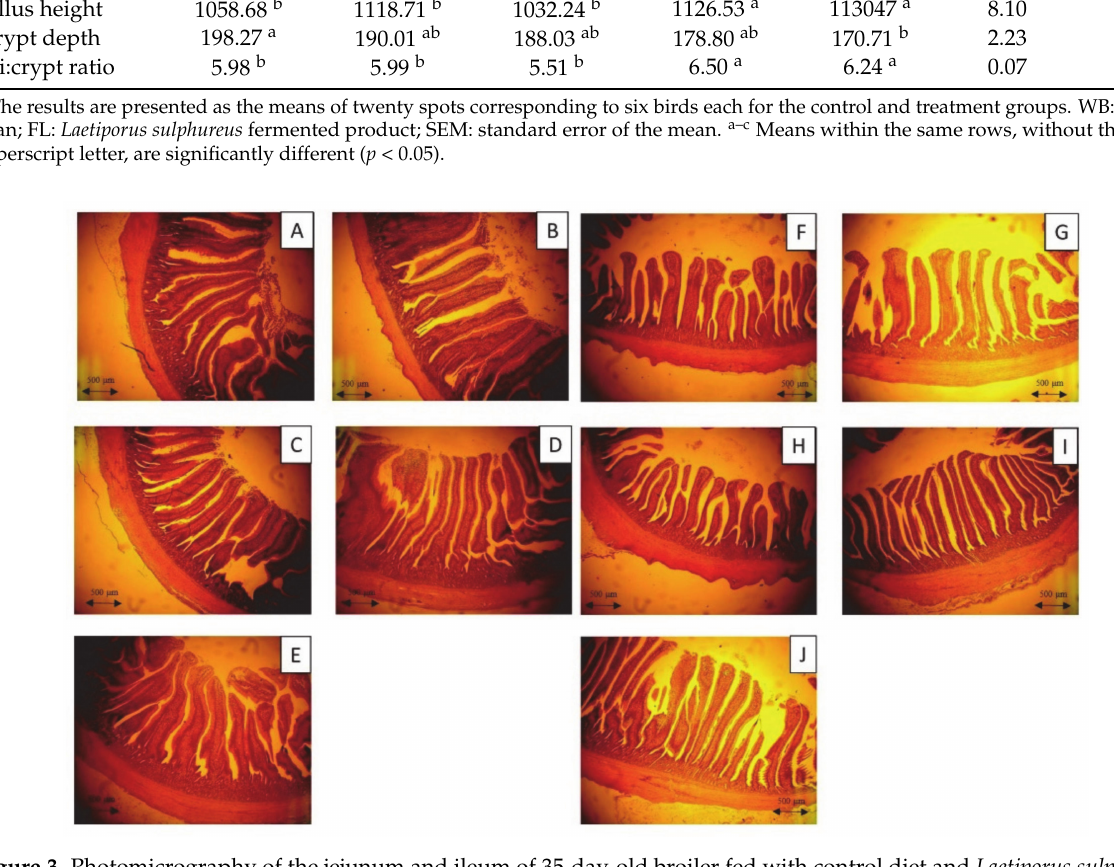
Figure 3. Photomicrography of the jejunum and ileum of 35-day-old broiler fed with control diet and Laetiporus sulphureus fermented product. ( A )–( E )—the jejunum of 35-day-old broilers representing the control, 5% WB, 10% WB, 5% FL, and 10% FL groups, respectively. ( F )–( J )—the ileum of 35-day-old broilers representing the control, 5% WB, 10% WB, 5% FL, and 10% FL groups, respectively. Haematoxylin and eosin stain (40 ×